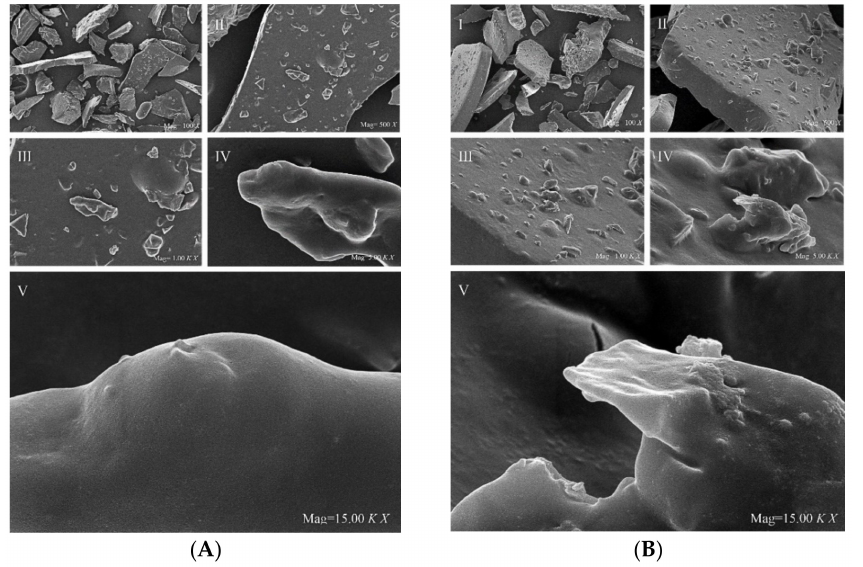
Figure 4. SEM images of PFSI-1 ( A ), PFSI-2 ( B ). (Note: Polysaccharide features viewed in PFSI-1 ( A ) and PFSI-2 ( B ) I at 100 × magnification; II, III at 500 × and 1000 × magnification microscopy; IV, V at 5000 × and 15,000 ×